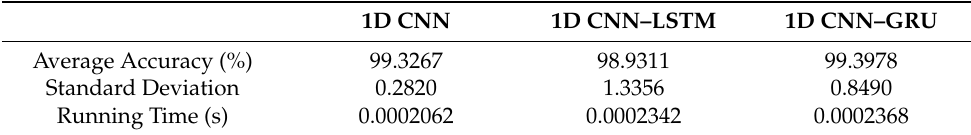
Table 8. The classification results of the optimized 1D CNN-based networks using the new dataset. 1D CNN 1D CNN–LSTM 1D